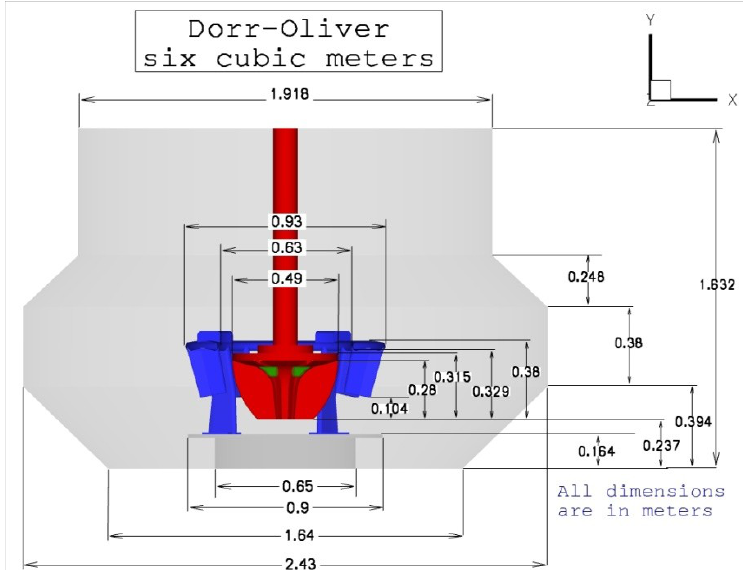
Figure 1. Overall dimensions of a 6 m 3 model of Dorr-Oliver flotation cell.